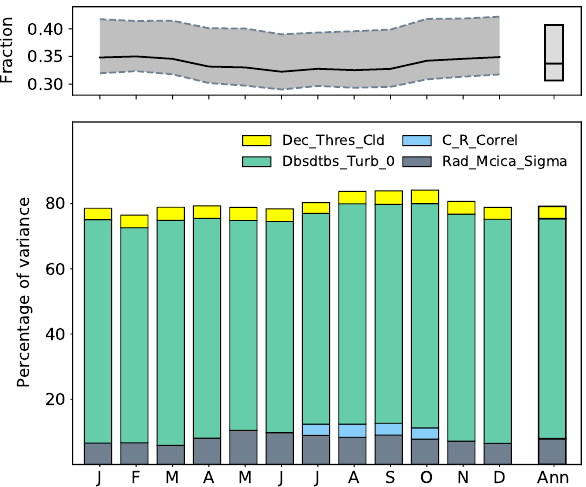
Figure 8. Percentage contributions to variance in present- day (2008) global, monthly and annual mean low-altitude cloud amount. Figure features are identical to Fig. 4.